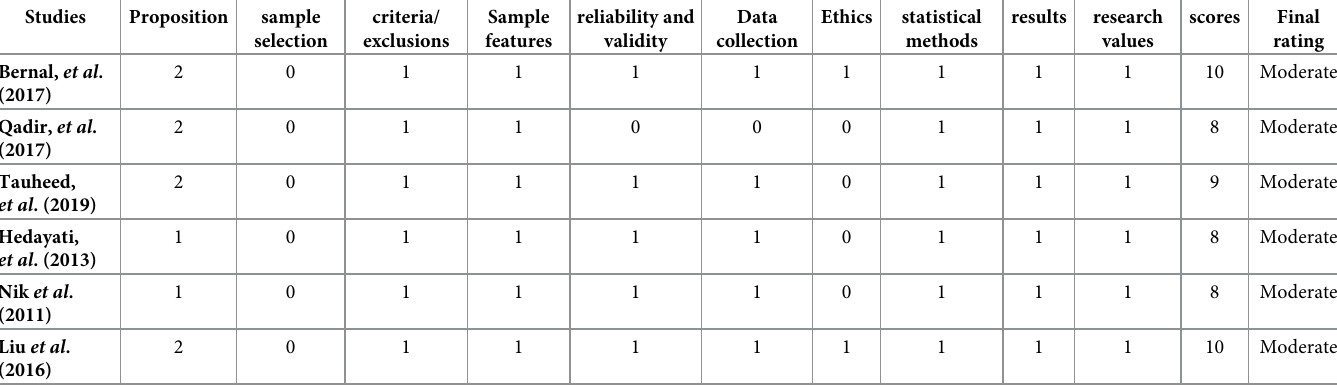
Table 3. Quality assessment of included studies.